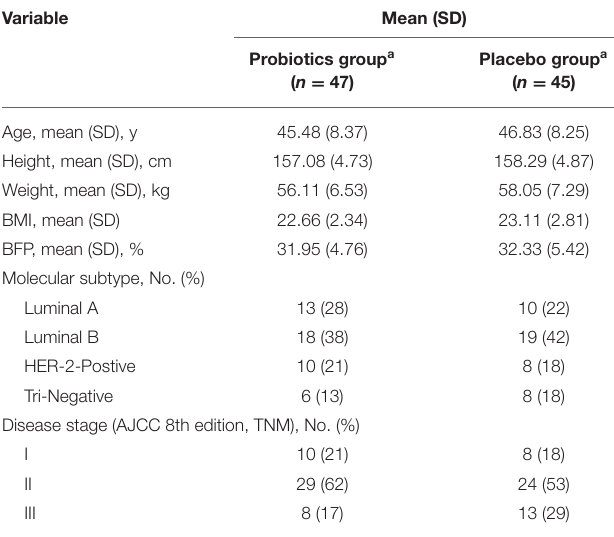
TABLE 1 | The baseline demographic and clinical characteristics of patients.